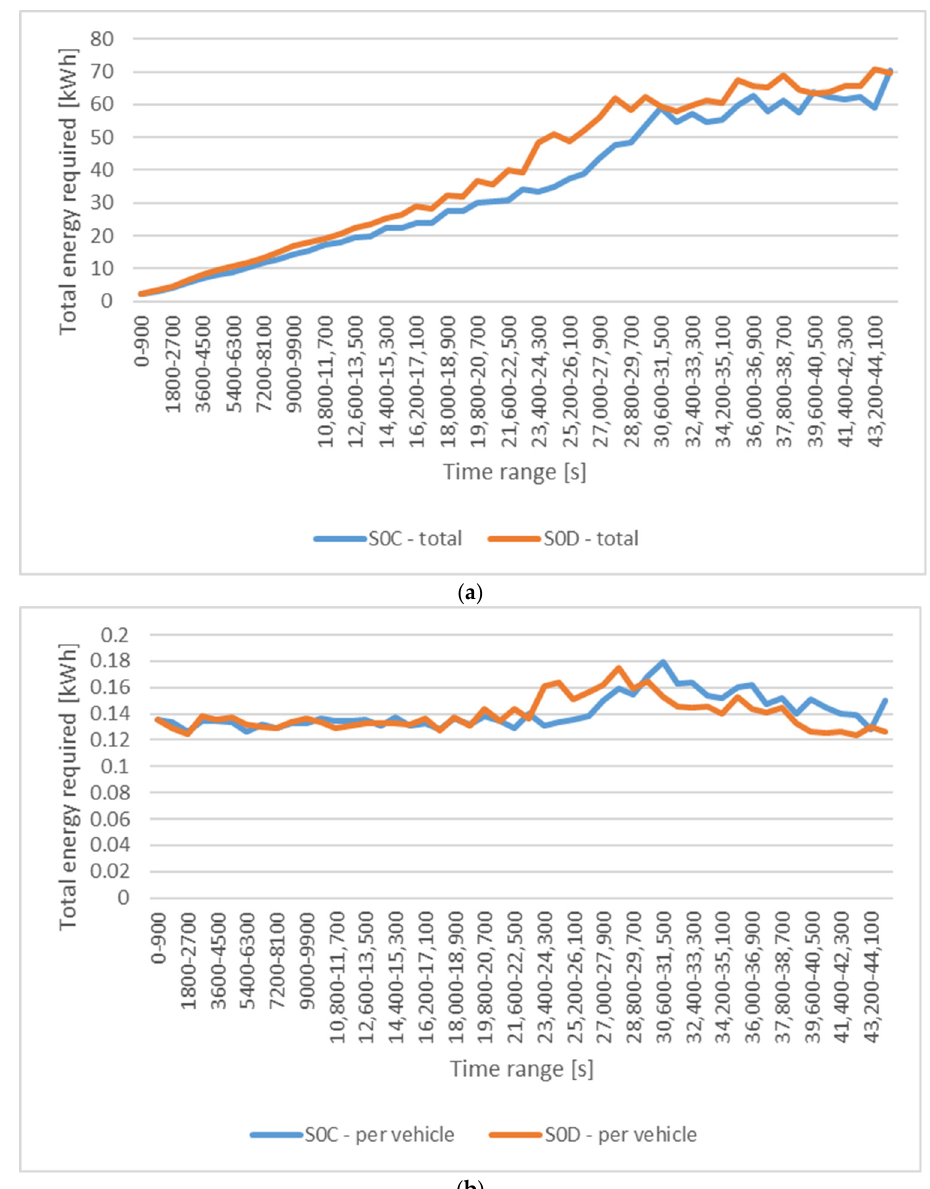
Figure 10. Comparison of required energy between scenarios S0C and S0D: ( a ) total energy required in each simulation interval; ( b ) required energy per vehicle in each simulation